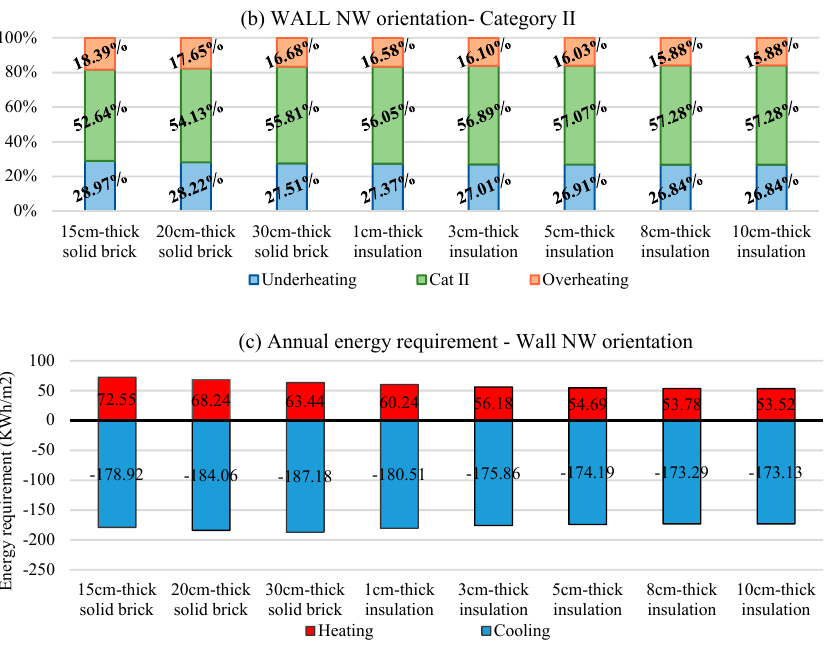
Figure 14. Comfort rates according to the static ( a ) and the adaptive ( b ) approach and annual energy requirement ( c ) for the wall W2 with NW orientation according to different insulation thicknesses.